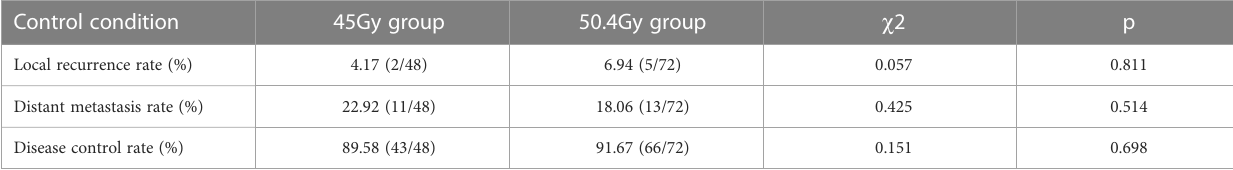
TABLE 3 Disease control